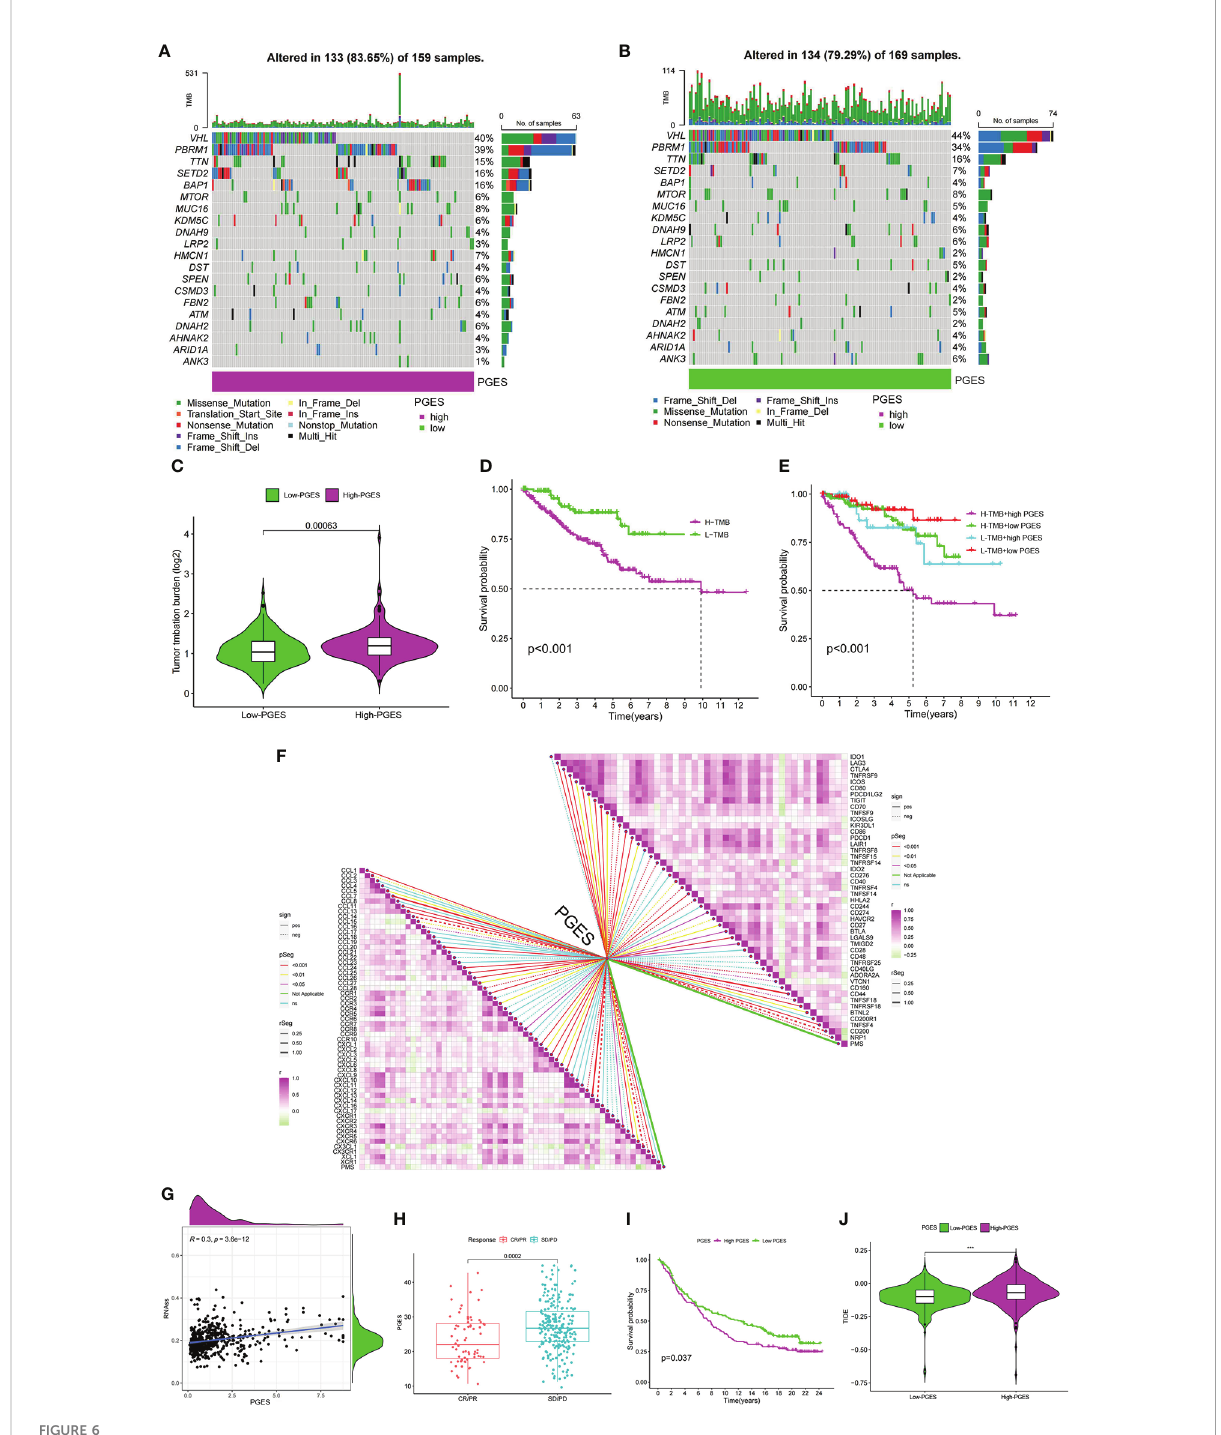
FIGURE 6 Predictive value of PGES on ccRCC immunotherapy. (A, B) The waterfall plot shows the mutation frequency of the high- and low-PGES groups. (C) TMB differences between high and low PGES. (D) K – M curve of survival difference between high and low TMB. (E) K – M curve of survival difference strati fi ed by TMB and PGES. (F) Correlation analysis of PGES with immune checkpoint and chemokines. (G) Correlation analysis between PGES and stemness indices. (H) Boxplot shows PGES difference between CR/PR and SD/PD. (I) K – M curve of difference in overall survival between high and low PGES. (J) Difference in TIDE between high and low PGES. PGES, polyamine gene expression score; ccRCC, clear cell renal cell carcinoma. ***p <